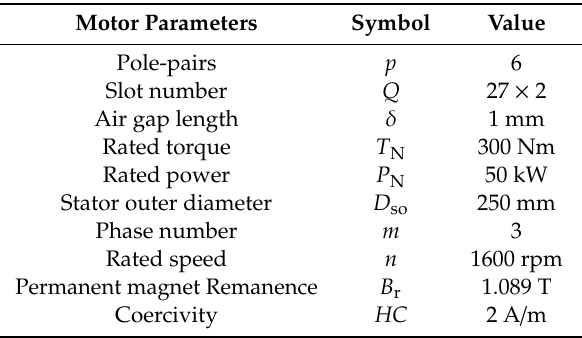
Figure 1. Double stator-single rotor type axial flux permanent magnet synchronous motor (AFPMSM).